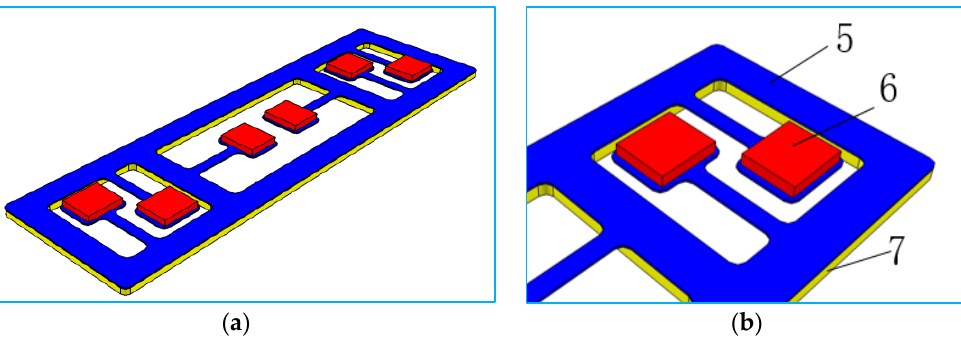
Figure 16. Mathematical model of acoustic metamaterial. ( a ) The designed local resonance acoustic metamaterial, ( b ) the local resonance unit.